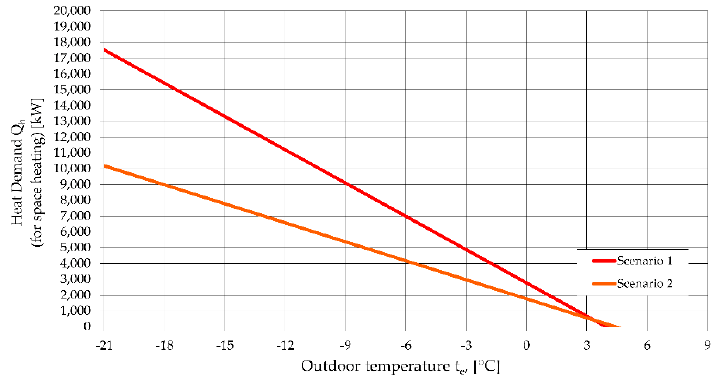
Figure 3. Thermo-energy footprints of the reference urban areas for the study scenarios under a stationary regime.